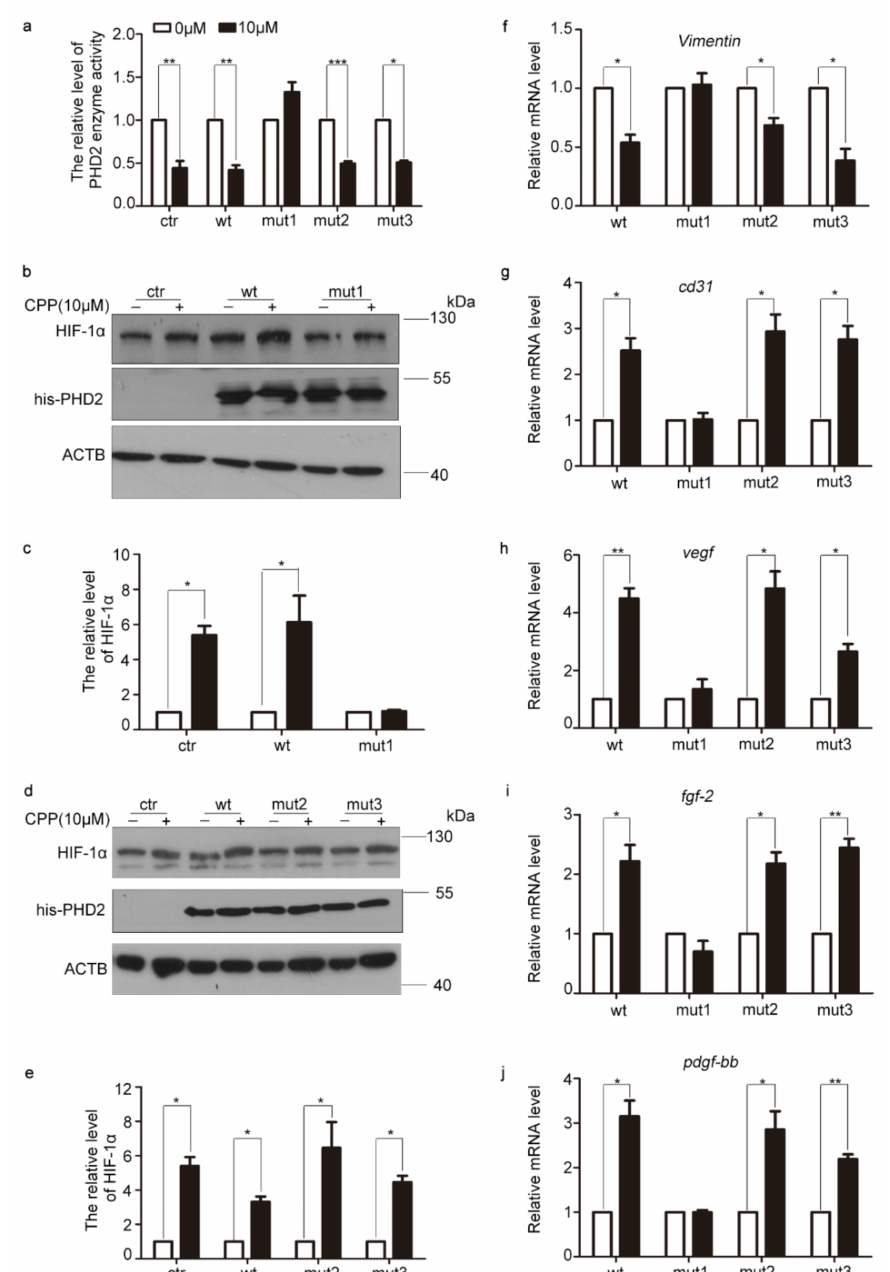
Figure 5. CPP induces HDFs to differentiate into vascular endothelial cells by inhibiting the oxidation of PHD2 at Cys302. ( a ) HDFs were transfected with pCDNA-his6 (ctr), pCDNA-his6- PHD2 (wt), pCDNA-his6-PHD2-C302A (mut1), pCDNA-his6-PHD2-C323A (mut2) and pCDNA- his6-PHD2-C326A (mut3) for 24 h, and then were treated with CPP (10 µ M) for 48 h, after